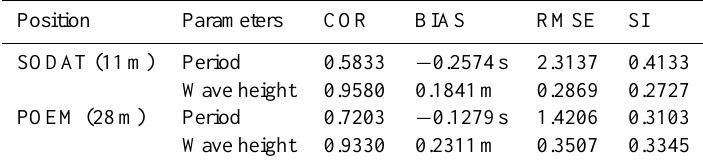
Table 2. Statistical comparison between data and simulations at WW3-TET scale, at SODAT and POEM.